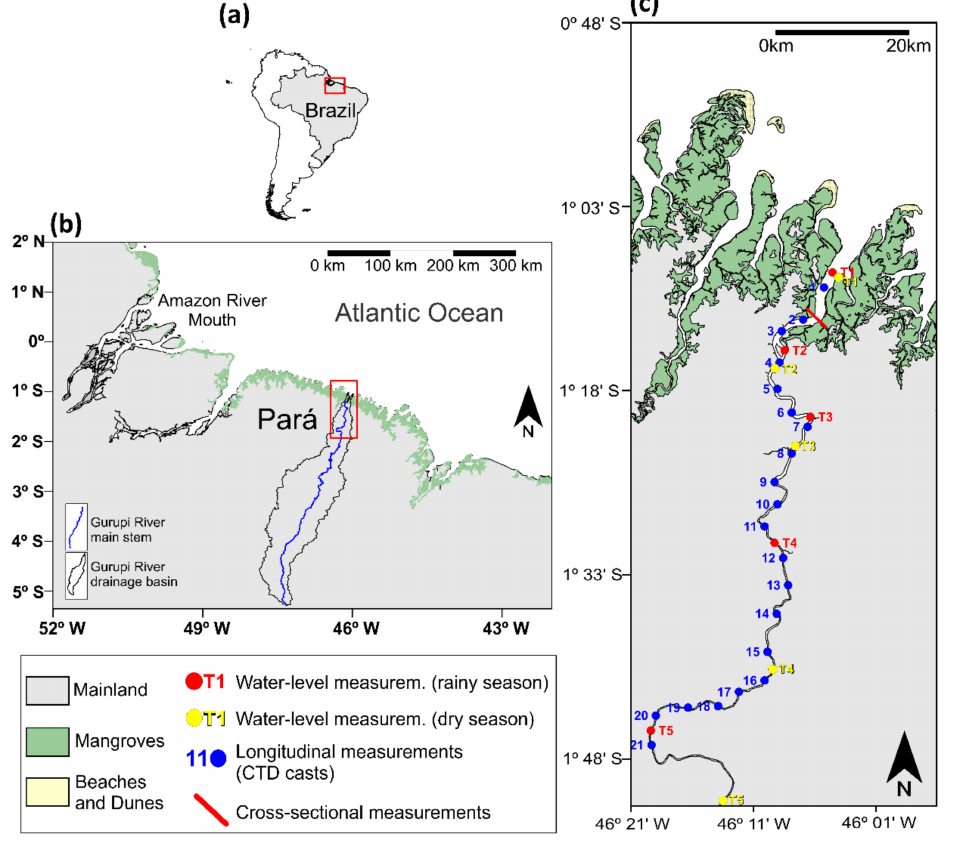
Figure 1. The location of ( a ) South America, ( b ) the Amazon Coastal Zone, and ( c ) the Gurupi River estuary, with sampling